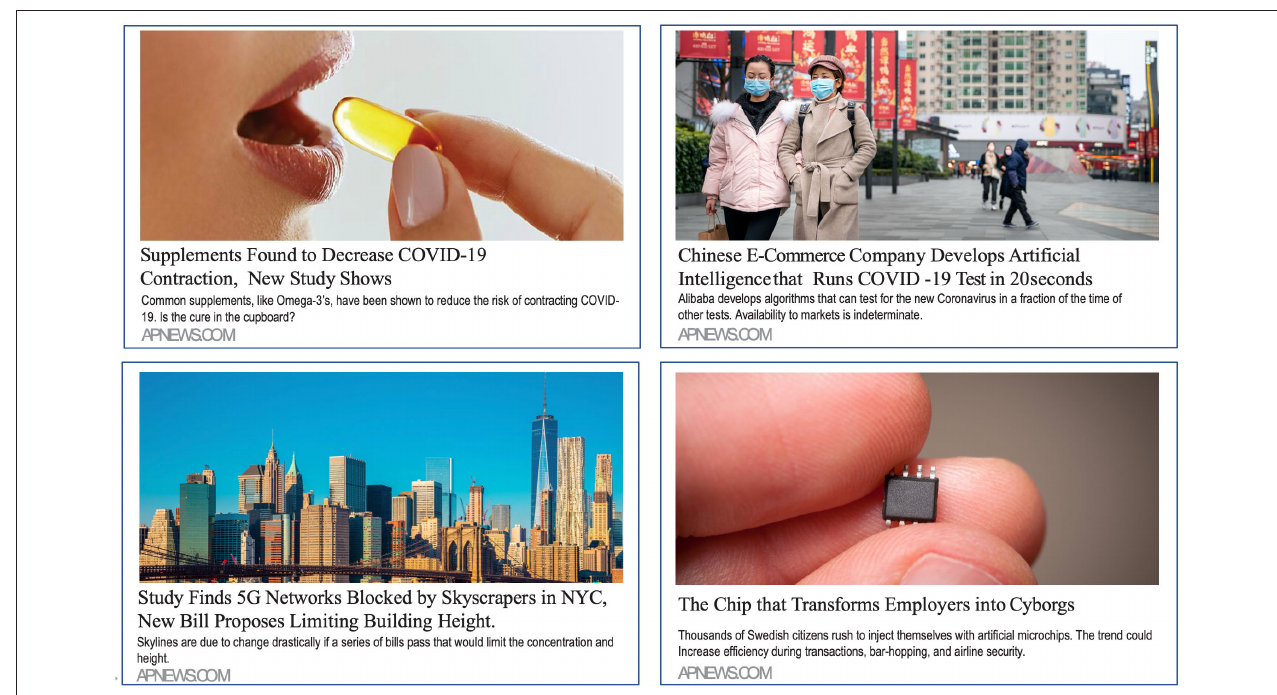
FIGURE 2 | Examples of fake news headlines presented to participants. We report one example for each type: Top left, COVID-19-related fake news; top right, COVID-19-related real news; bottom left, neutral fake news; bottom right, neutral real news. © Images purchased from shutterstock.com. **significance at p < 0.01; ***significance at p <